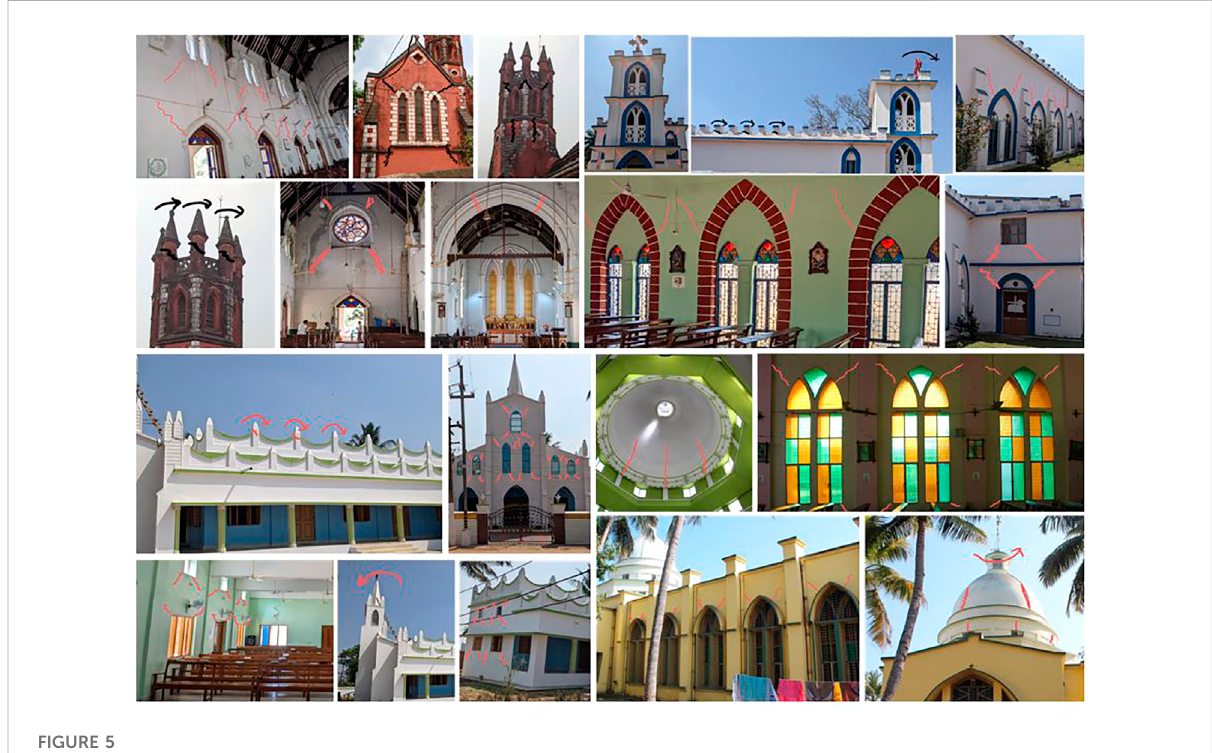
FIGURE 5 Possible collapse mechanisms in the analyzed churches.